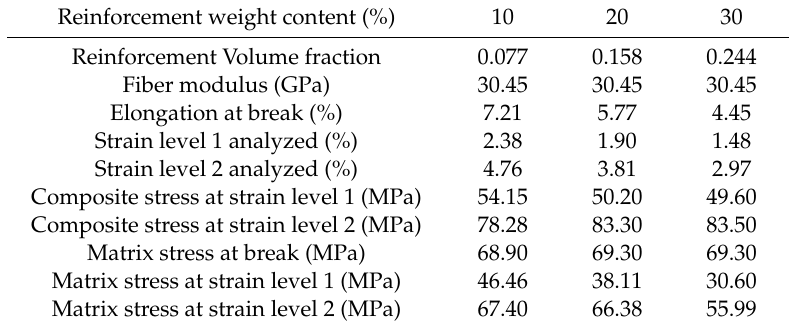
Figure 6. Length distribution of the original BHF and the BHF incorporated to PA6 at different content. Table 3. Data used to solve Kelly and Tyson modified equation by using Bowyer and Bader